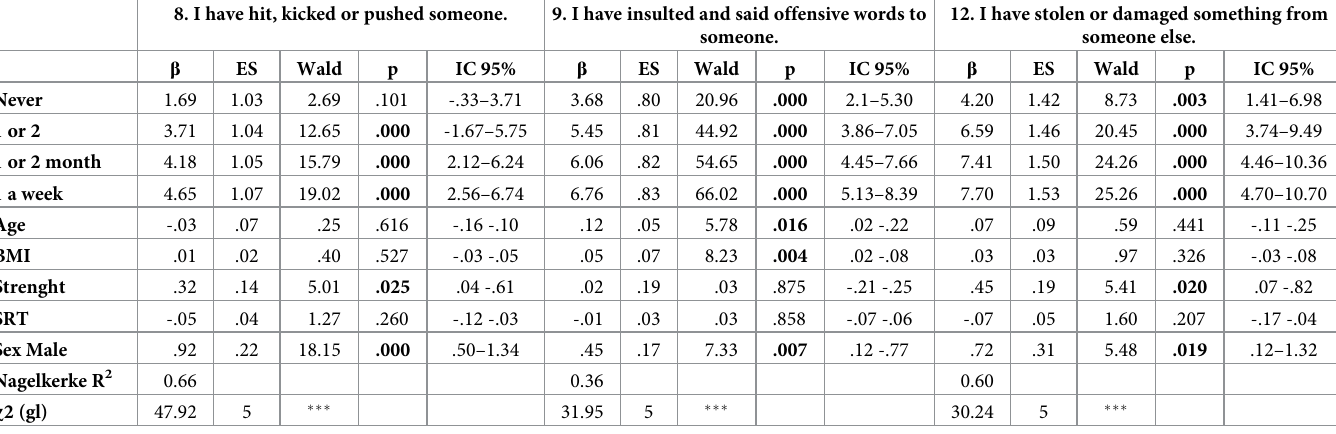
Table 8. Ordinal regression analysis with age, height, weight, Strength Cardiorespiratory fitness and gender, as cross-sectional predictors of aggression behaviours. 8. I have hit, kicked or pushed